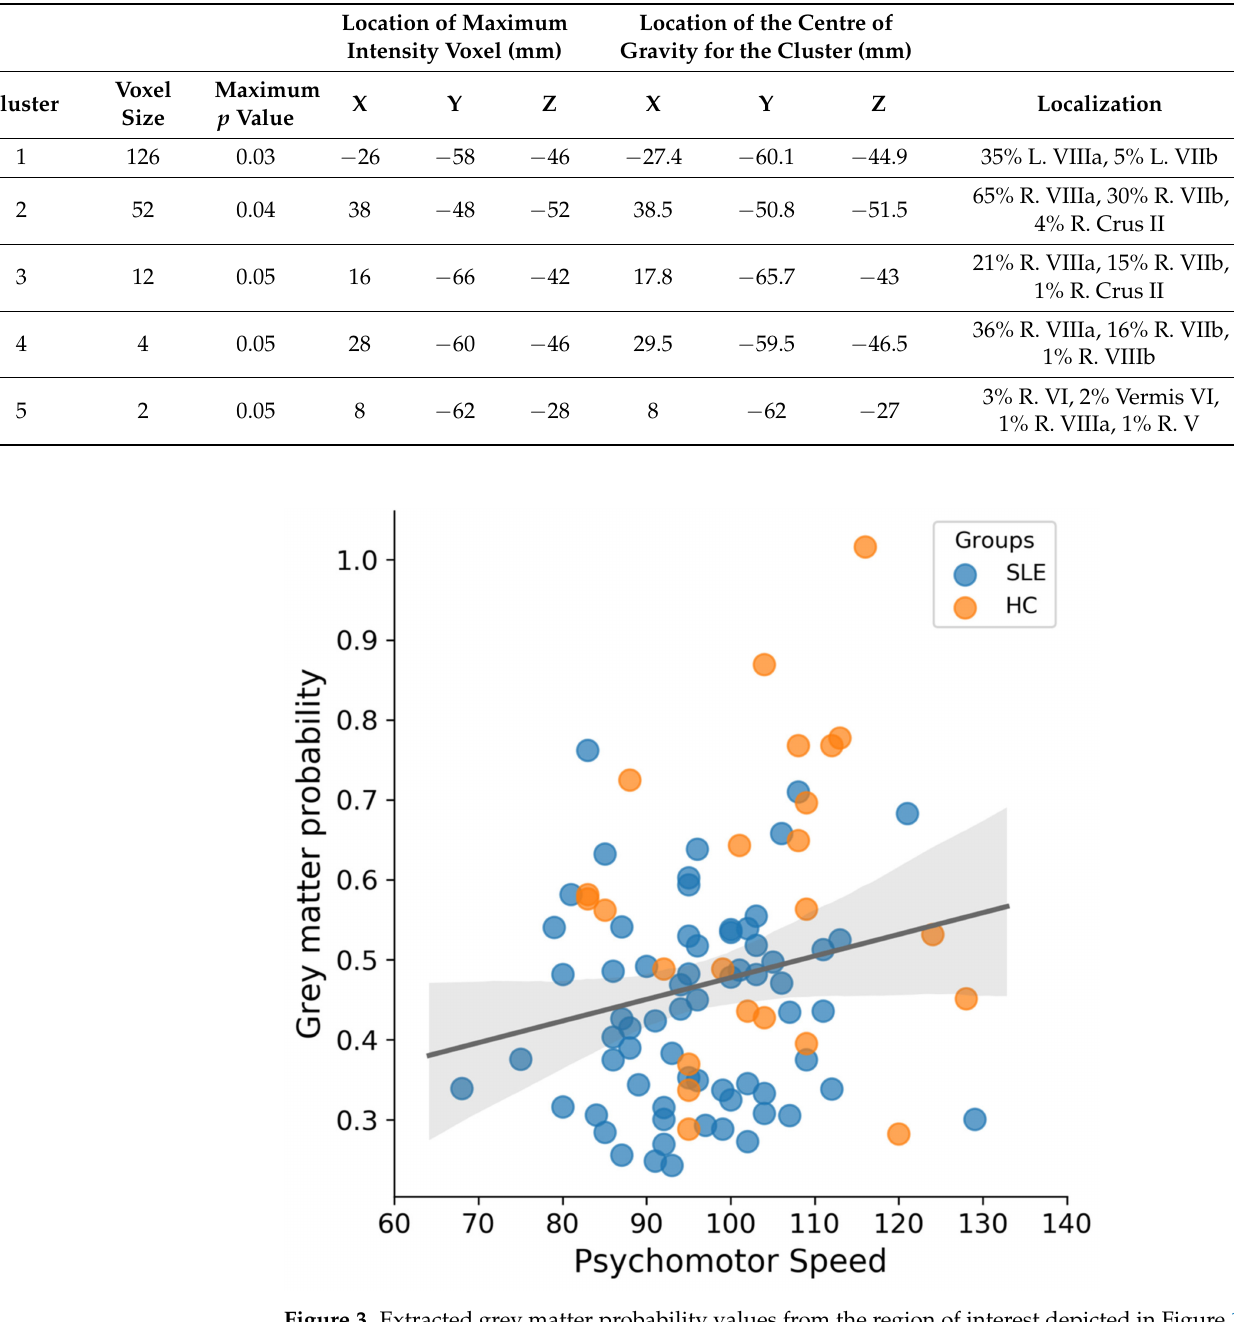
Figure 3. Extracted grey matter probability values from the region of interest depicted in Figure 1 A correlate weakly with psychomotor speed ( p = 0.05, r = 0.21), suggesting that the VIIIa of the cerebel- lum is involved in motor activity. The image depicts patients with Systemic Lupus Erythematosus (SLE) and Healthy Controls (HC) in separate